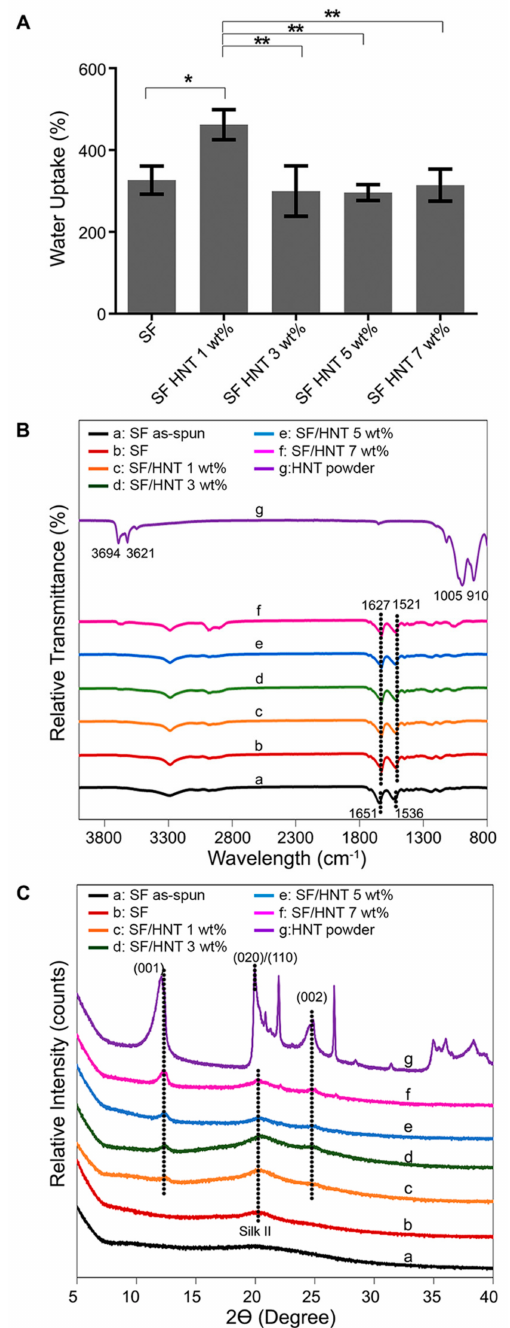
Figure 3. Characteristics of the scaffolds. ( A ) Water uptake capacity of SF scaffolds and SF/HNT composite scaffolds. All tests were performed on 5 replicates. Means ± SD are shown. Statistical analyses were ANOVA followed by Tukey’s test. * p ≤ 0.05, ** p ≤ 0.01. ( B ) FTIR spectra of as-spun SF scaffolds, methanol-treated SF scaffolds, and SF/HNT composite scaffolds. ( C ) XRD pattern of SF/HNT composite scaffolds and as-received